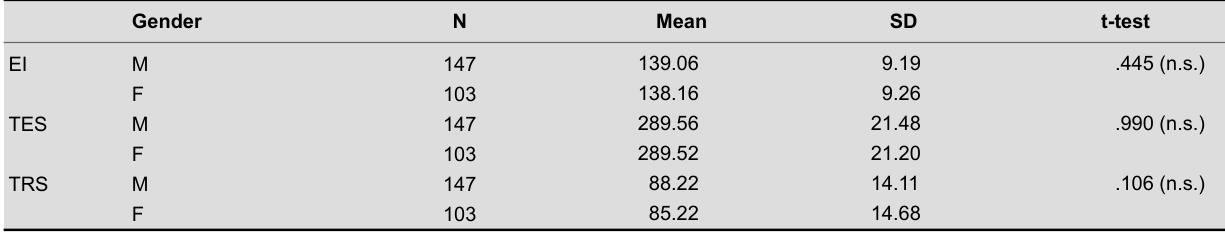
Difference in EI, TES and TRS of Male and Female Faculty